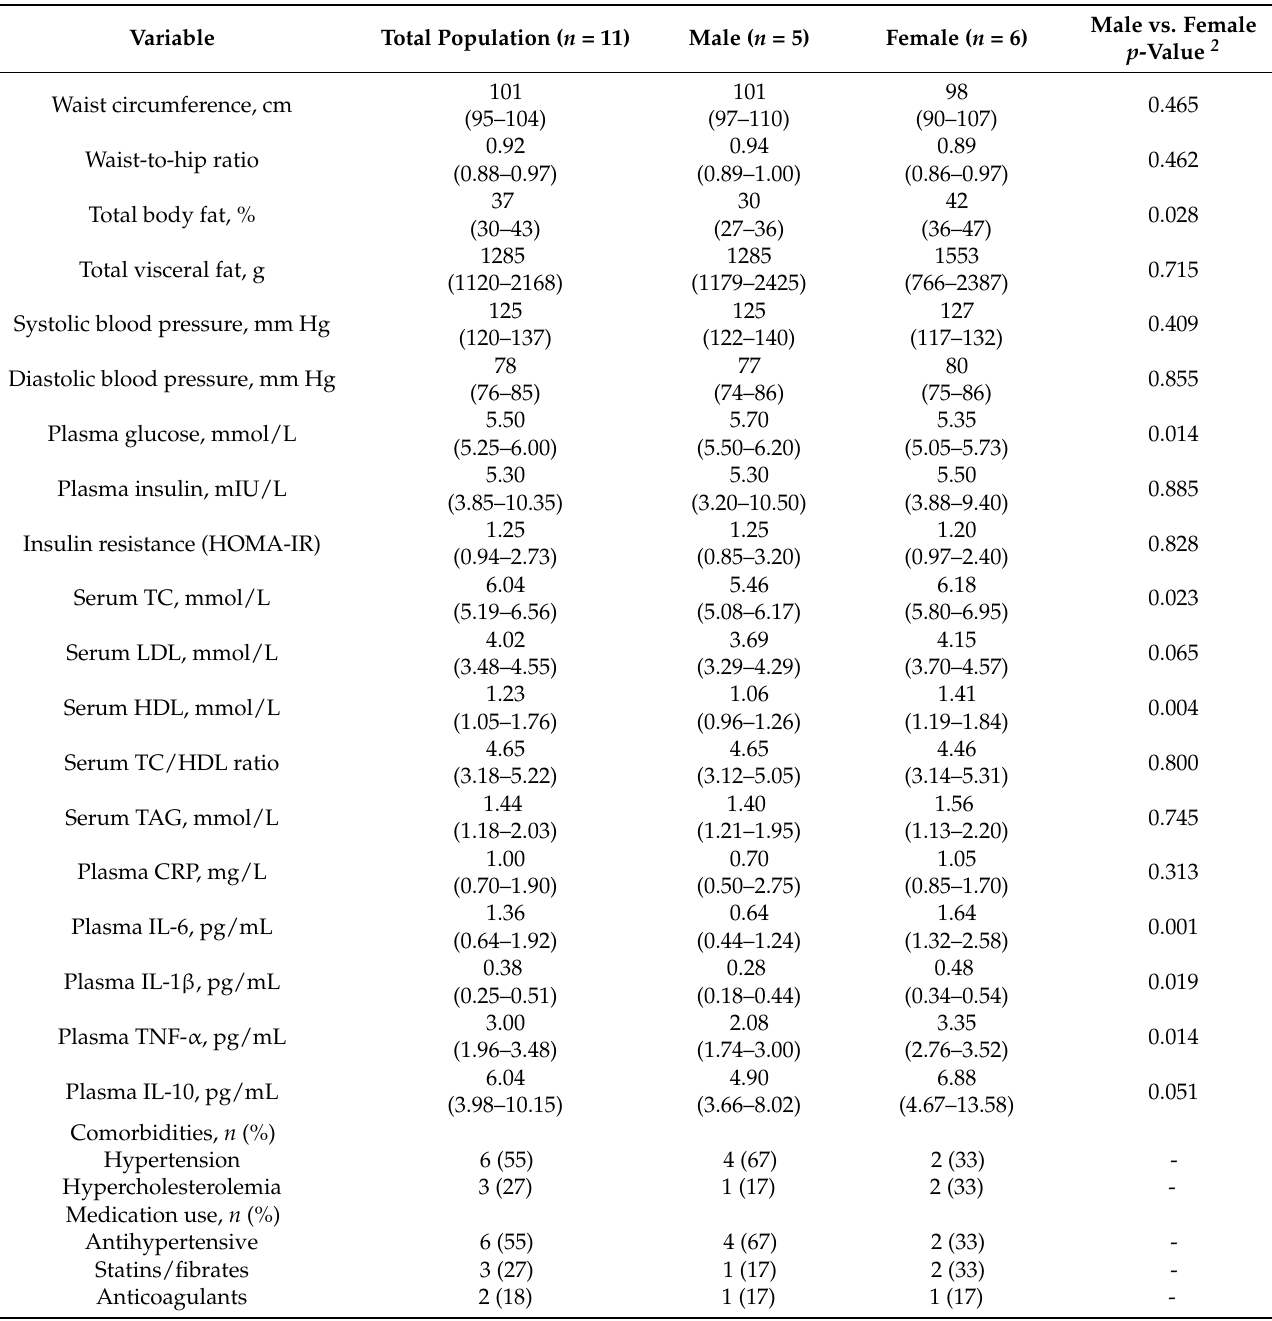
Table 2. Baseline physical and biochemical characteristics of study participants 1